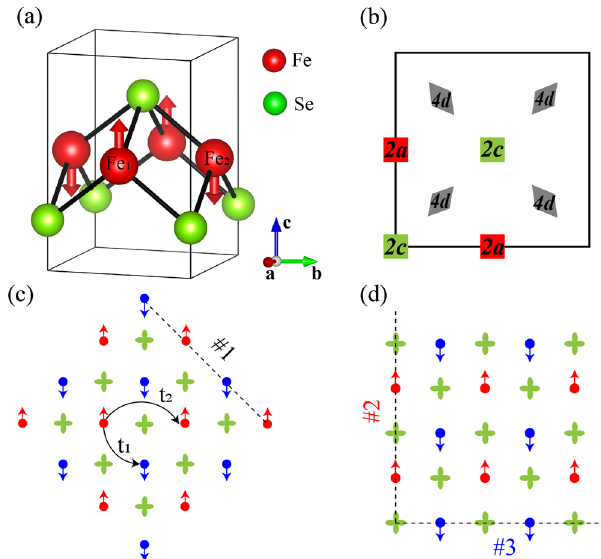
Fig. 1 Illustration of the unit cell and three boundary cuts for cb- AFM monolayer FeSe. a The crystal and magnetic structure of monolayer FeSe. b Maximal symmetry Wyckoff positions in MSG P 4 0 / n 0 m 0 m . Since monolayer FeSe is 2D, only the z = 0 Wyckoff positions are manifested. c , d Three distinct boundary cuts. Cut #1 represents the boundary of AFM edge. Cuts #2 and #3 represent the boundary of FM edge with spin-up and spin-down polarization along c-direction.